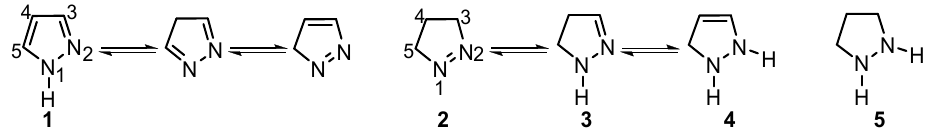
Figure 1. Chemical structures and numbering of pyrazole 1 , dihydropyrazole (pyrazoline) tautomers 2 – 4 and pyrazolidine 5 .